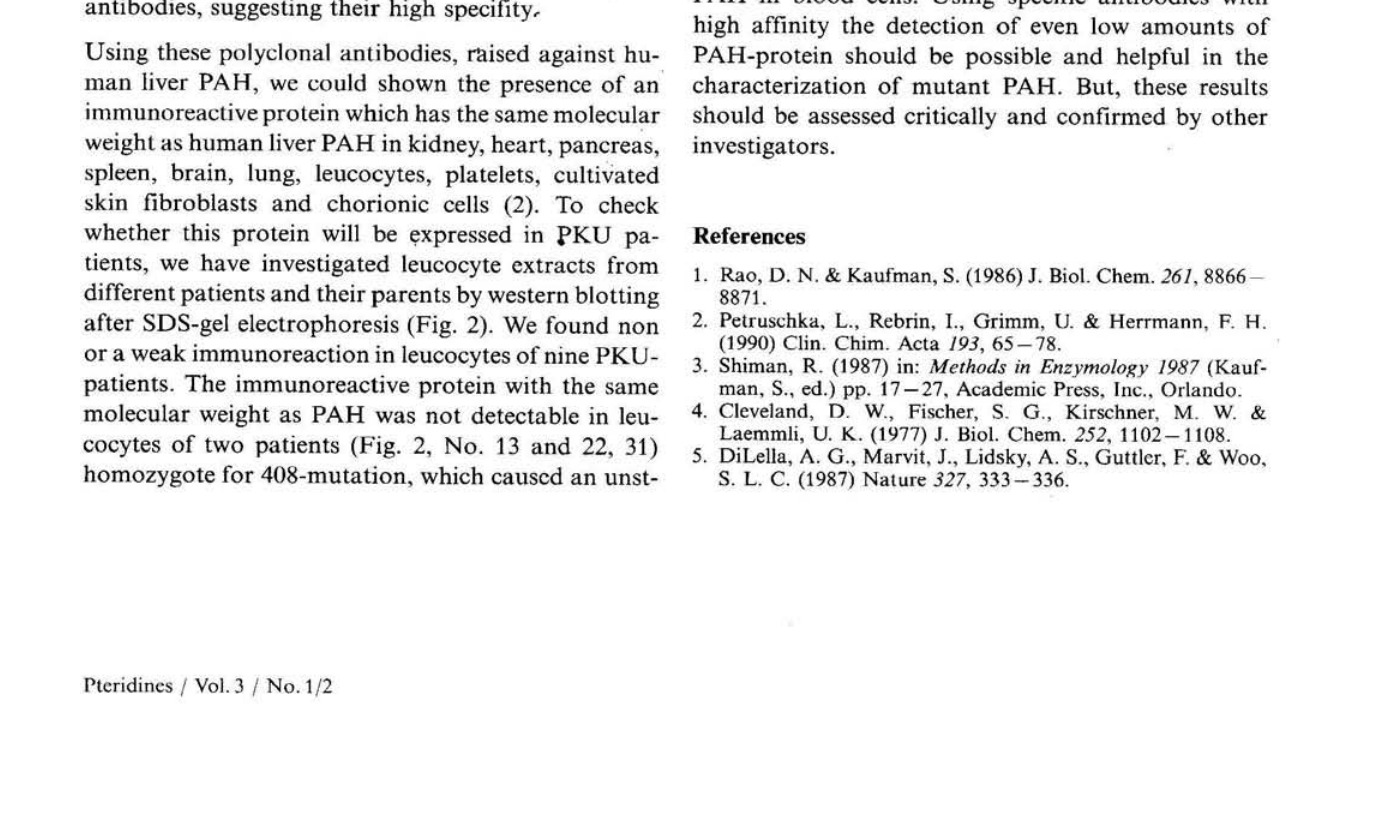
Figure 2. Western blot-analysis in leukocytes of PKU-families. Crude human liver extract — 01, 02; purified PAH — 03, 04; PKU - 05; PKU (6/1) - 06; M-06 (8/6) - 07; F-06 (1/4) - 08; PKU - 09; M-09 - 10; F-09 - 11; M-13 (7/2) - 12; PKU (2/2) - 13; F-13 (2/4) - 14; M-14 - 15; PKU - 16; F-16 - 17; human liver - 18, 19; purified PAH - 20; PKU (2/2) - 21; PKU - 22; PKU - 23; F-27 - 25; M-27 - 26; PKU - 27; F-29 - 28; PKU - 29; M-29 - 30; PKU